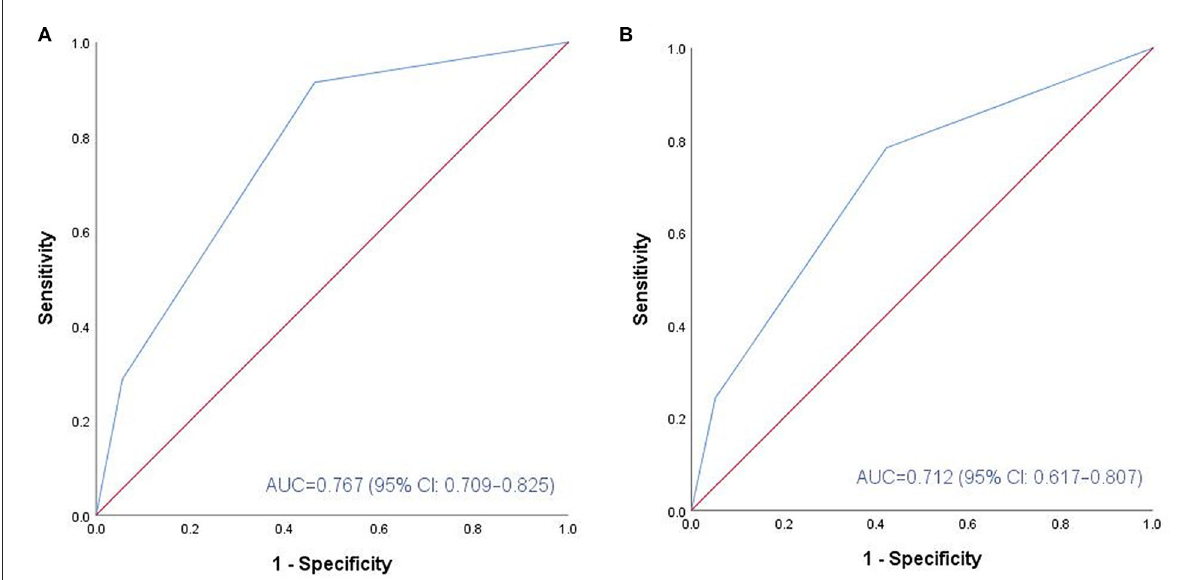
FIGURE2 ROC analysis of the association between F-NLR score and functional outcome at 3 months before and after PSM. (A) Before PSM, F-NLR score showed promising predictive performance (AUC: 0.767, 95% CI: 0.709-0.825; P < 0.001). (B) After PSM, F-NLR score still performed well